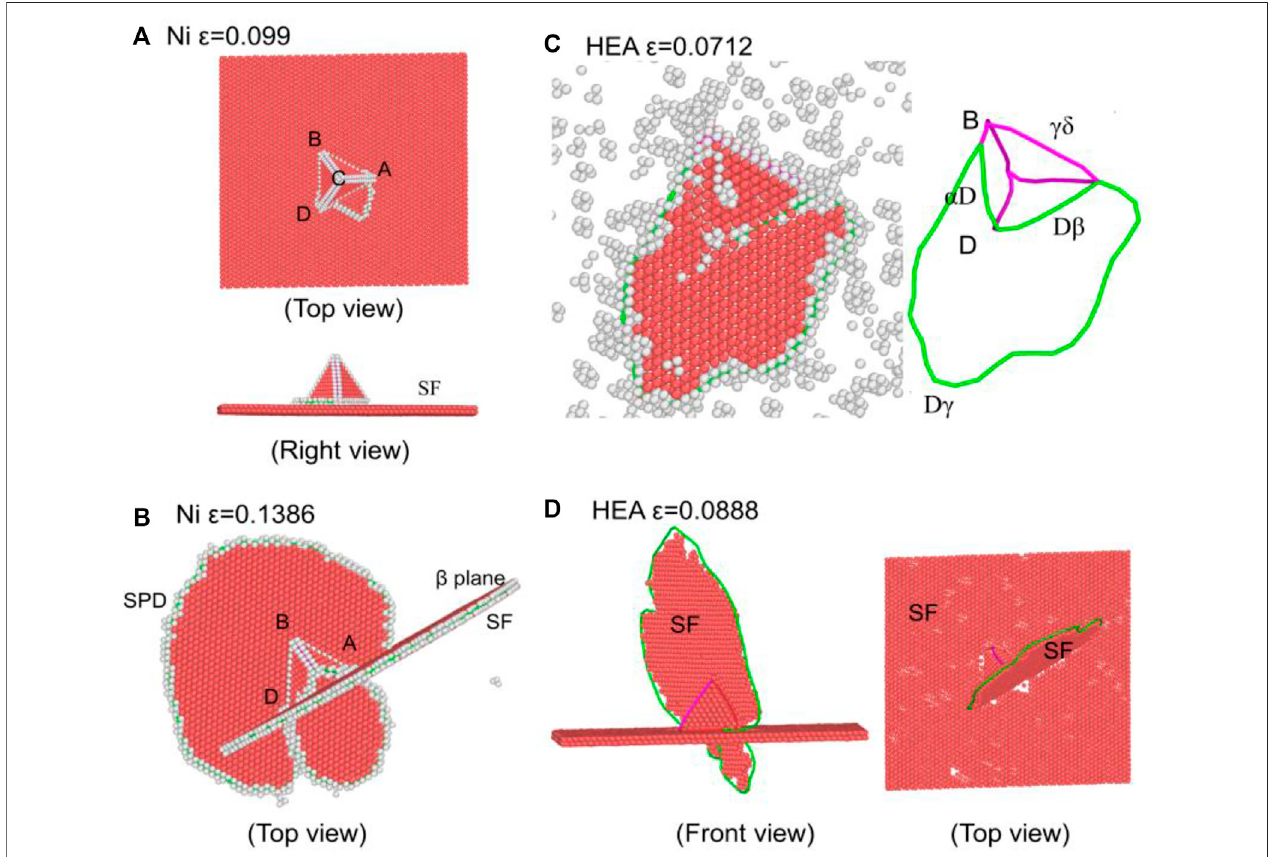
FIGURE 7 | Atomic structures of SFTs in Ni and CoCrFeNiMn samples sheared along ( 111 )[ 110 ] at different shear strains, (A,B) Ni. (C,D) CoCrFeNiMn HEA.